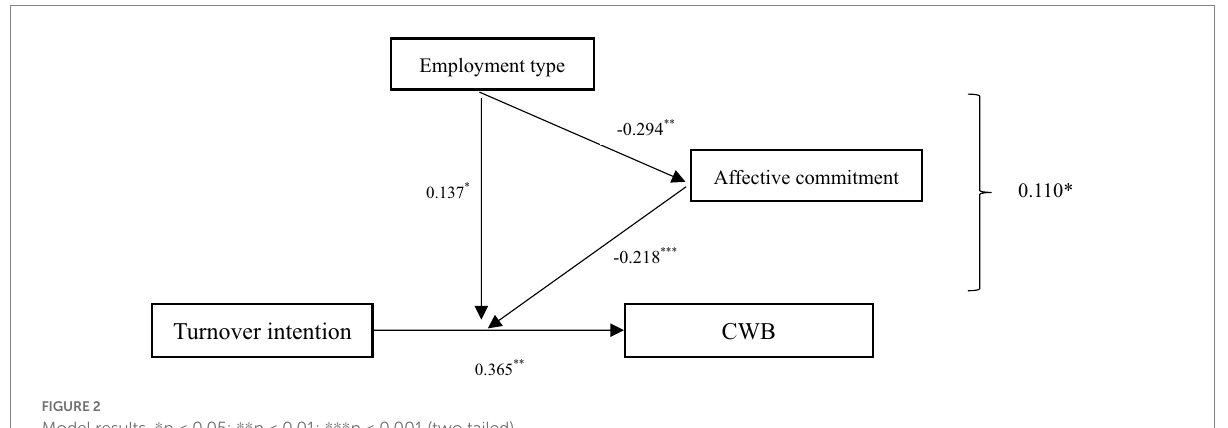
FIGURE 2 Model results. * p < 0.05; ** p < 0.01; *** p < 0.001 (two